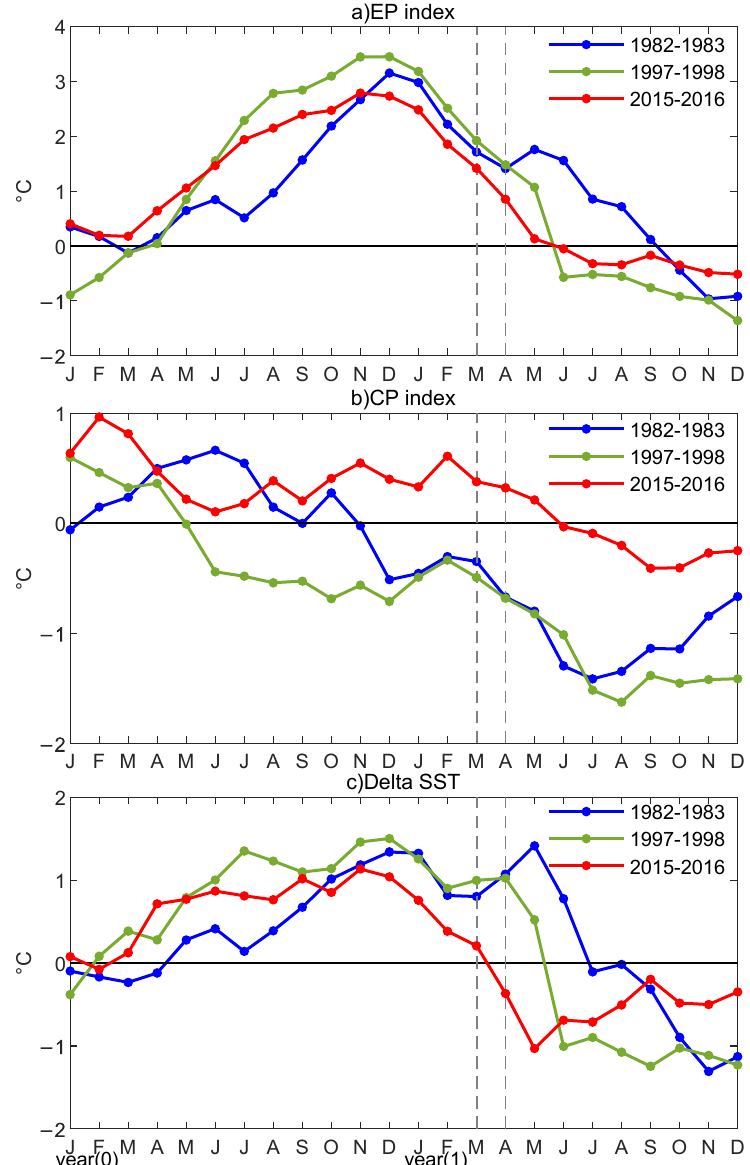
Figure 8. Time evolution of three indices: ( a ) EP index; ( b ) CP index and ( c ) zonal-mean delta SST. For each subfigure, 1982/1983 event (blue), 1997/1998 event (green), 2015/2016 event (red).